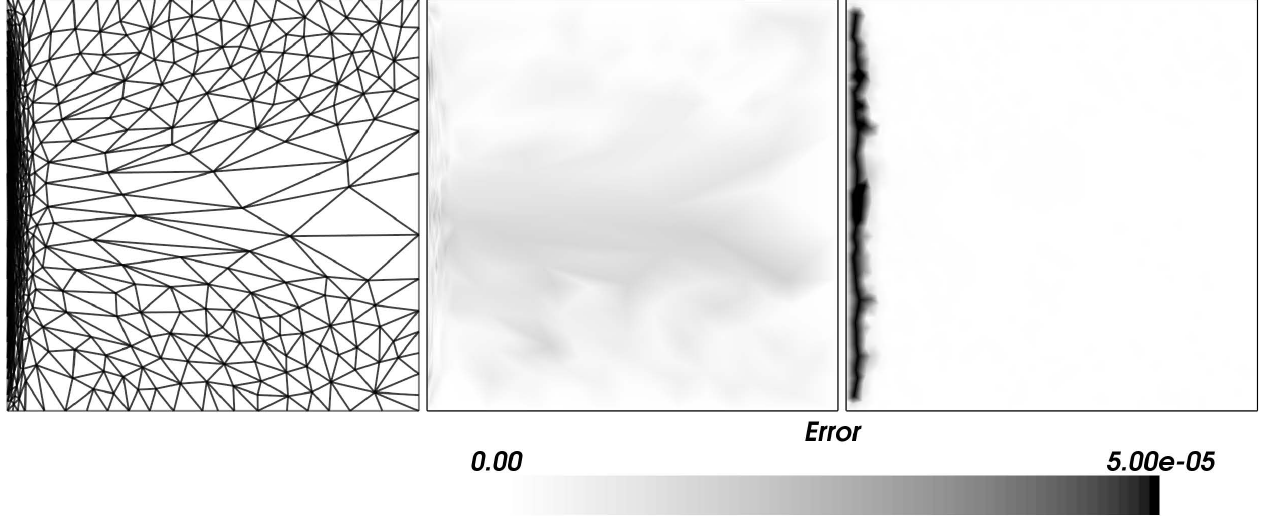
Fig. 7. Left: the adapted mesh in the Stommel western boundary current test. The mesh can be seen to be refined anisotropically in the vicinity of the western boundary. Centre and right: the absolute values of the difference between the numerical and analytical solutions in the case of the adapted (centre) and uniform (right) meshes. The uniform mesh has approximately four times the number of nodes compared to the adapted mesh. Large errors can be seen with the uniform mesh which has insufficient resolution to resolve the rapidly changing streamfunction close to the western